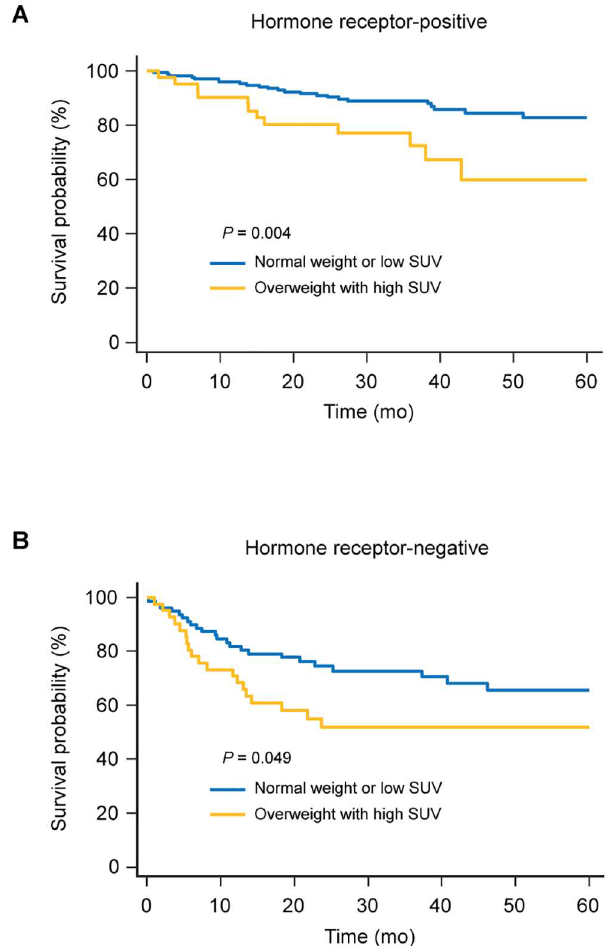
Fig 1. Kaplan-Meier survival curves for recurrence-free survival according to BMI with tumor SUV in patients with hormone receptor-positive (A) and-negative disease (B). BMI, body mass index; SUV, standardized uptake